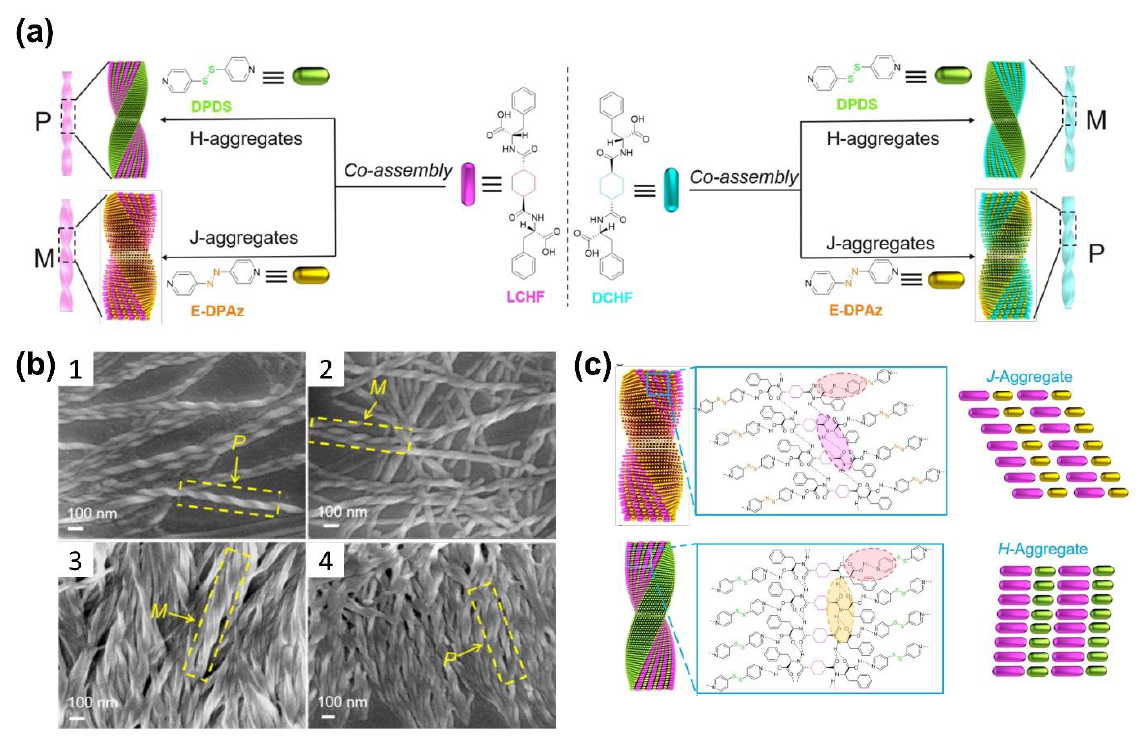
Figure 8. ( a ) Schematic presentation of the helical inversion triggered by H-aggregation of DPDS and J-aggregation of EDPAz in the co-assembly process with (left) LCHF or (right) DCHF. M represents left-handed helical nanofibers, and P represents right-handed helical nanofibers; ( b ) SEM images of (1) LCHF + DPDS with P-helical nanofibers, (2) DCHF + DPDS with M-helical nanofibers, (3) LCHF + EDPAz with M-helical nanofibers, and (4) LCHF + EDPAz with P-helical nanofibers; ( c ) Schematic representation for loose J-type packing of LCHF + EDPAz-induced left-handed co-assembly (top) and compact H-type stacking of LCHF + DPDS-induced right-handed co-assembly (bottom). Reprinted with permission from [64]. Copyright 2018, American Chemical Society.